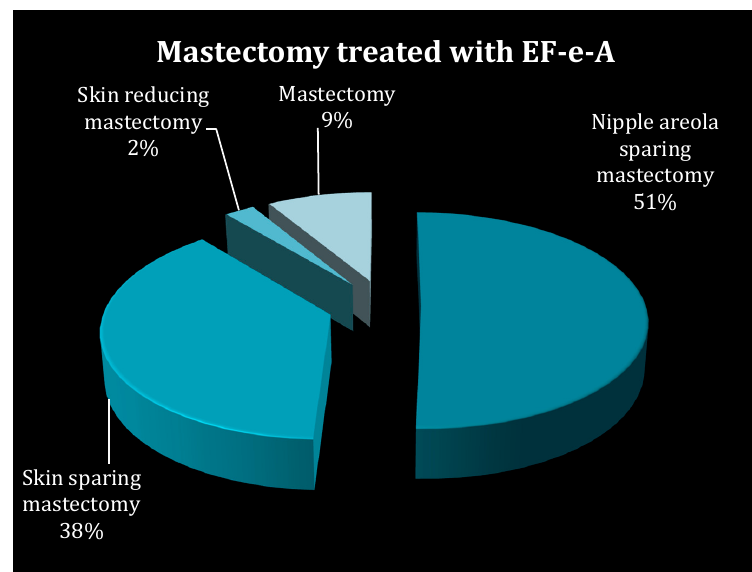
Figure 1. Clinical data of patients underwent oncoplastic surgery. Percentage of: Mastectomy (M); Nipple Areola Sparing Mastectomy (NASM); Skin Sparing Mastectomy (SSM); and, Skin Reducing Mastectomy (SRM).